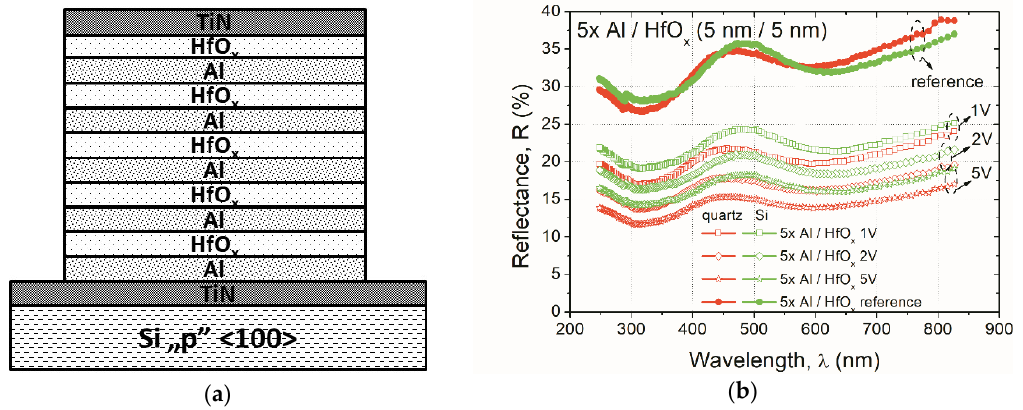
Figure 7. ( a ) Schematic cross-section of structure based on alternative (5x) Al and HfO x layers investigated in this study, and ( b ) change of e ff ective reflectance of examined stacks due to the external electrical polarization; the thickness of Al, HfO x , and TiN films was set at ~5 nm, ~5 nm, and 50 nm, respectively.